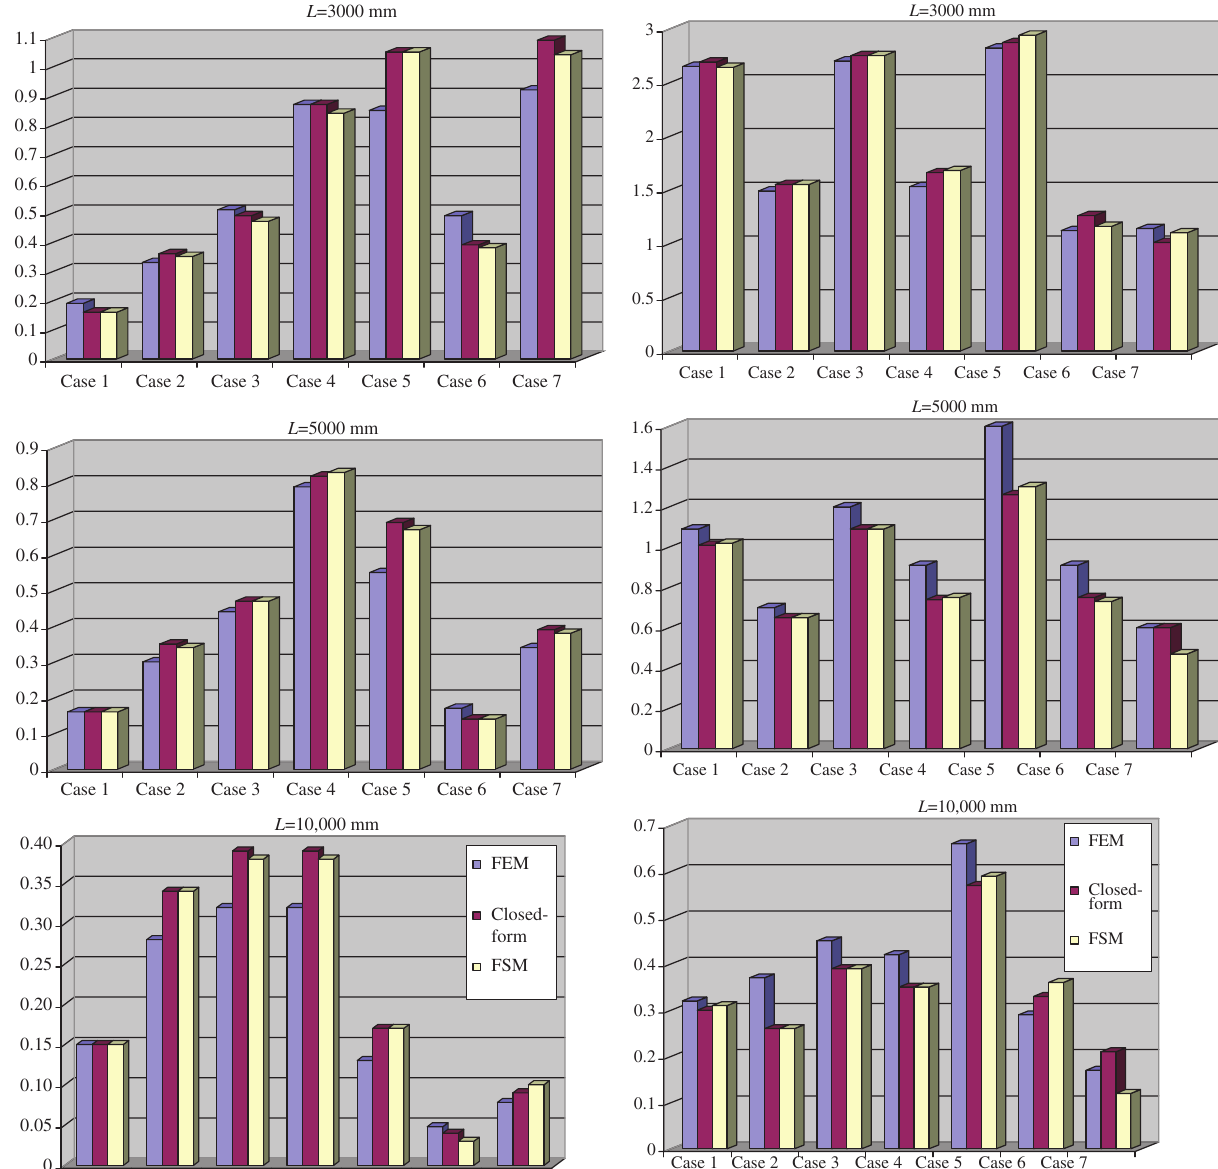
Figure 4 Comparisons of normalized buckling results for stiffened cruciform-shaped section. Figure 3 Comparisons of normalized buckling results for unstiff-